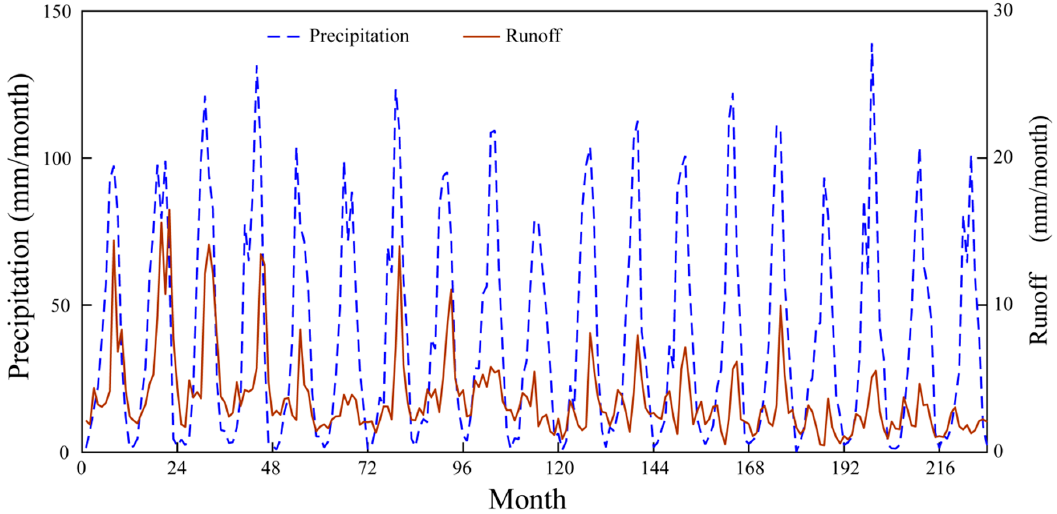
Figure 7. The monthly precipitation and runoff data across the Yellow River Basin. Table 5. Pearson correlation between the ET products and the corresponding precipitation and radiation forcing data. The ** and * indicate significant levels at 0.05 and 0.01 levels, respectively. Variable GLEAM E2O GLDAS MERRA